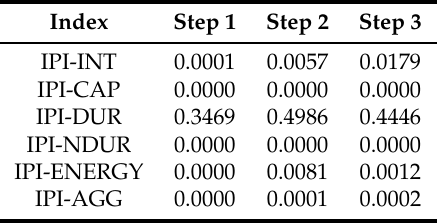
Table 21. Modified Diebold–Mariano statistics for the equality of forecast accuracy of two forecasts under general assumptions with an expanding window from 2015:01 to 2018:12. The null hypothesis is that the two methods have the same forecast accuracy. The Loss function is the absolute error.